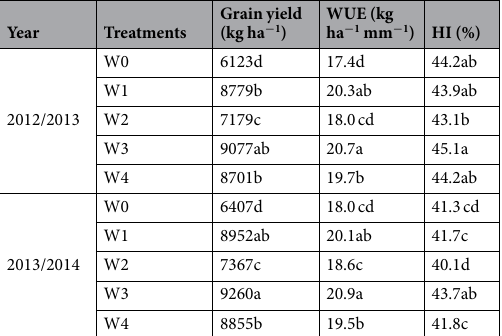
Table 3. The grain yield, water use efficiency (WUE), and harvest index (HI) in 2012/2013 and 2013/2014 growing seasons. W0: rainfed, W1: a local supplemental irrigation practice at jointing and anthesis with 60 mm each time, W2, W3 and W4 are supplemental irrigation determined by measuring 0–20 cm, 0–40 cm, and 0–60 cm soil layer moisture, respectively, and brought the soil moisture to 65% FC at jointing and 70% FC at anthesis. Within a column values followed by different letters differ significantly at the 0.05 level by the LSD test.